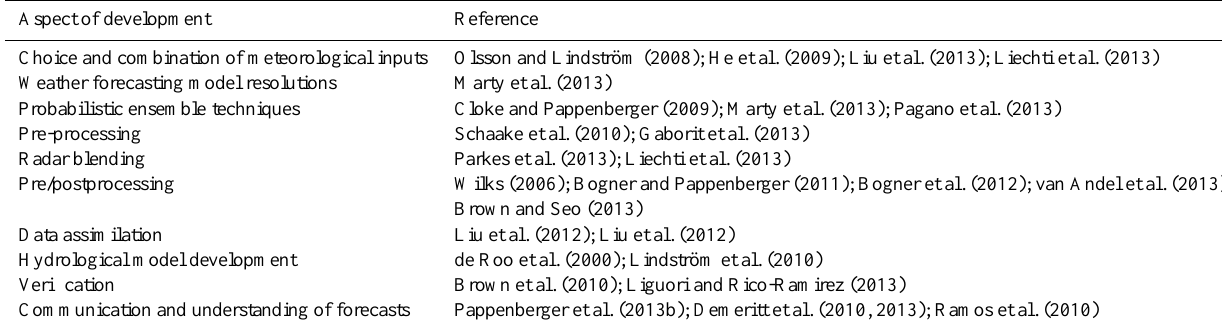
Table 2. Recent developments in operational